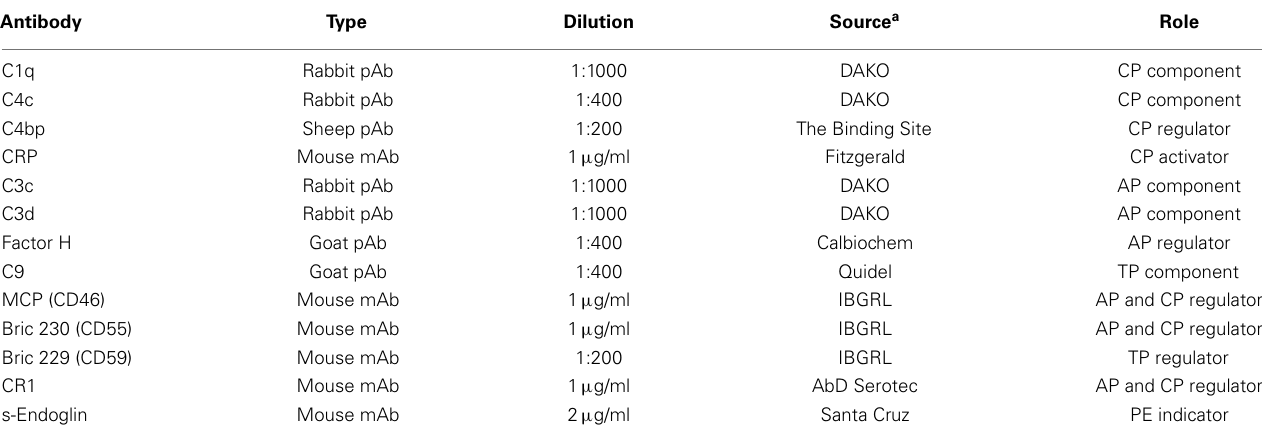
Table 2 | Primary antibodies used for immunofluorescence stainings .